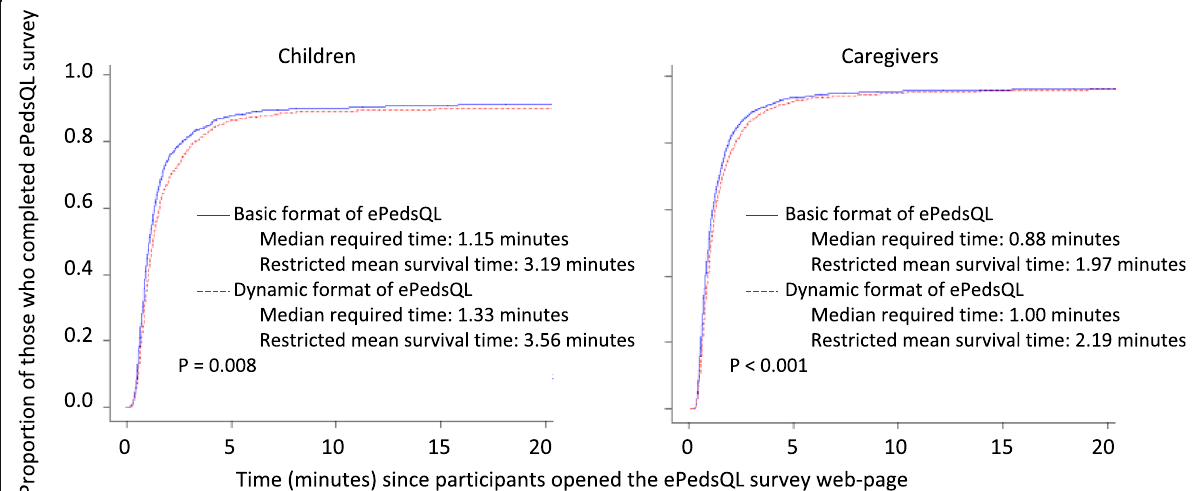
Fig. 3 Kaplan-Meier curve showing survey response time for two different ePedsQL formats for children (left) and caregivers (right). The Kaplan- Meier curves show the cumulative proportion of reporters who completed the ePedsQL survey and the time to completion from the time they opened the web-page. If the curve is shifted toward the left and top, this indicates that more reporters completed the survey in a shorter period of time